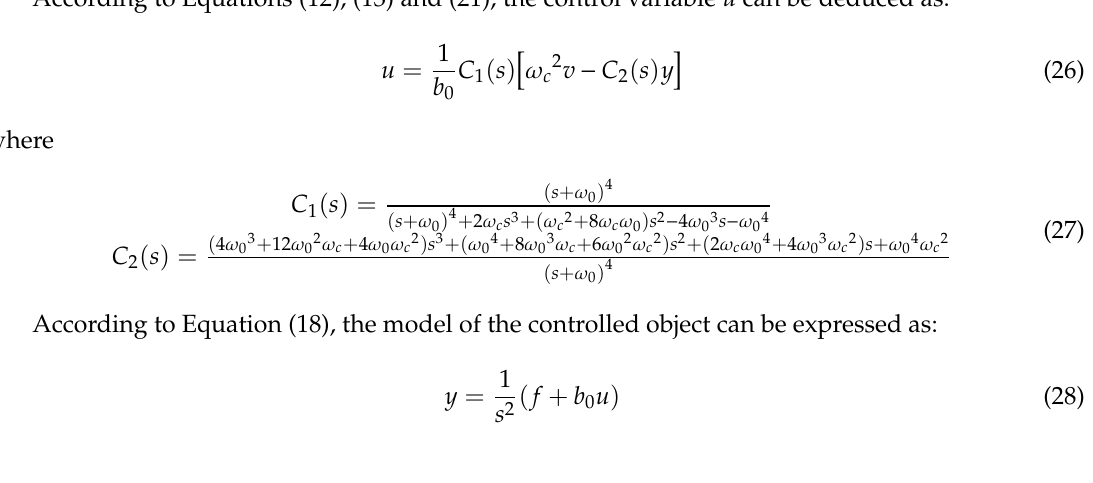
Figure 9. Frequency-domain characteristic curve of input disturbance.